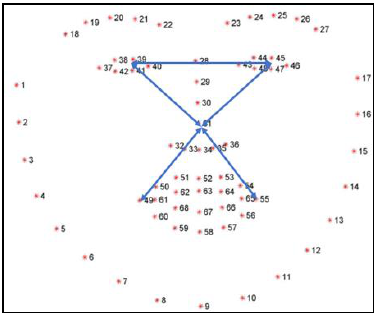
Figure 3. 5-point features [13].